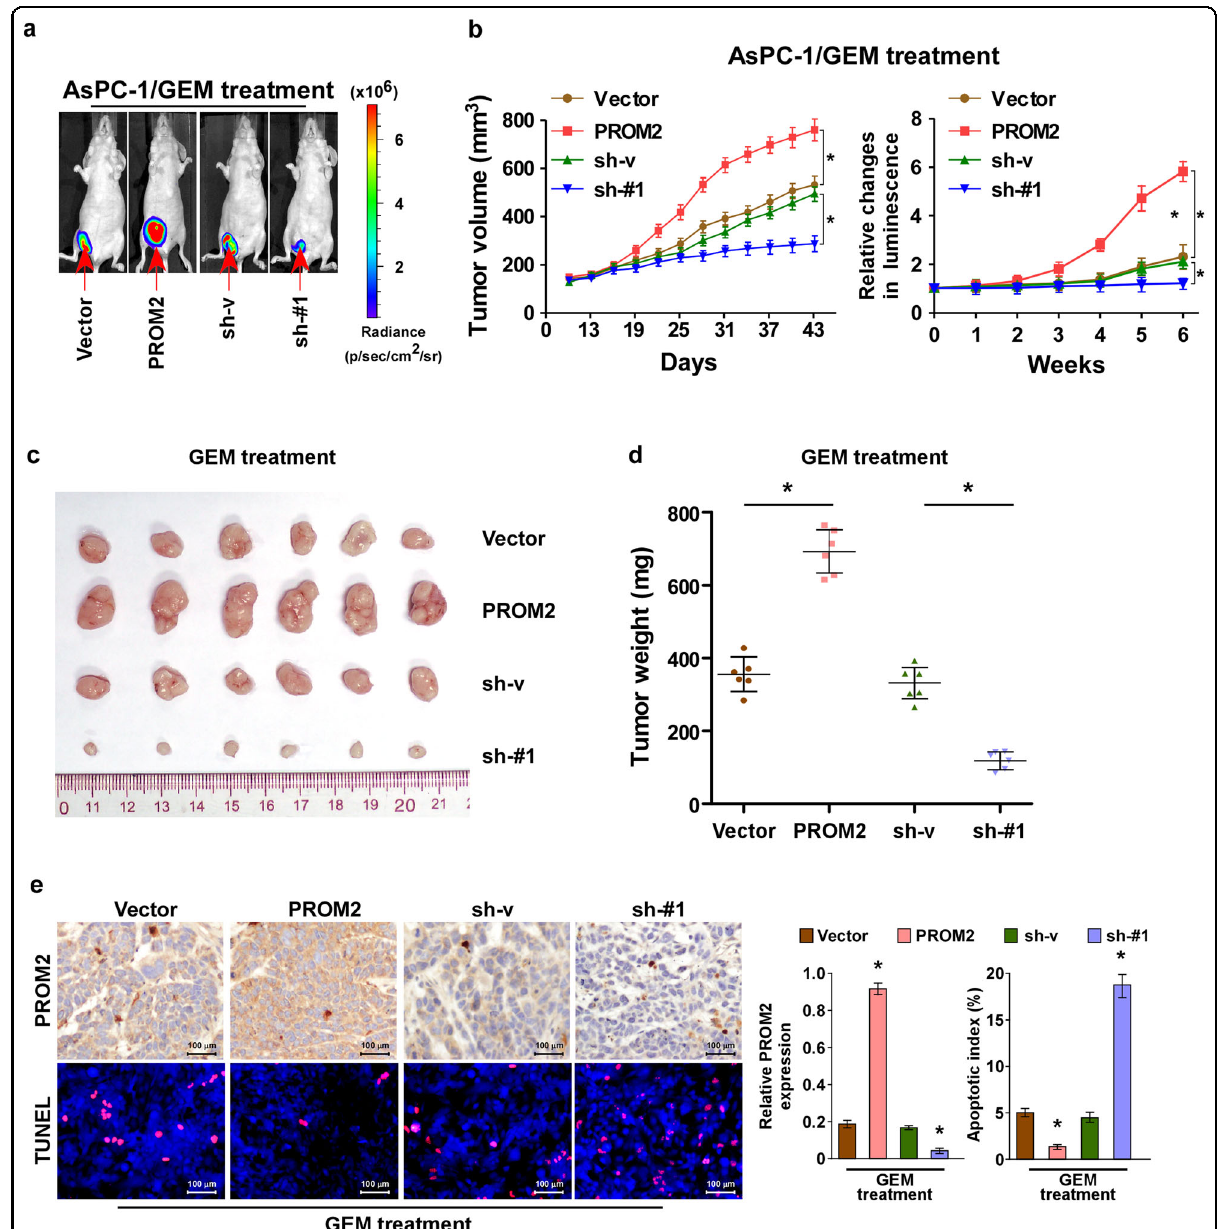
Fig. 4 PROM2 enhances gemcitabine chemoresistance in pancreatic cancer in vivo. a Luminescence signal of xenografted tumors formed by indicated cells in mice after gemcitabine treatment. b The changes of tumor volume and luminescence with gemcitabine treatment in indicated cells (mean value is plotted). c Representative images of tumor mass removed from mice with xenografted tumors. d Tumor weight (mg) of the collected tumor mass removed from mice xenografted with indicated cancer cells (* P <0.05). e Representative images of PROM2 and TUNEL immunostaining in indicated tumor tissues; the quanti fi cation of results is shown on the right panel (* P <0.05), the PROM2 expression of vector group has been set as